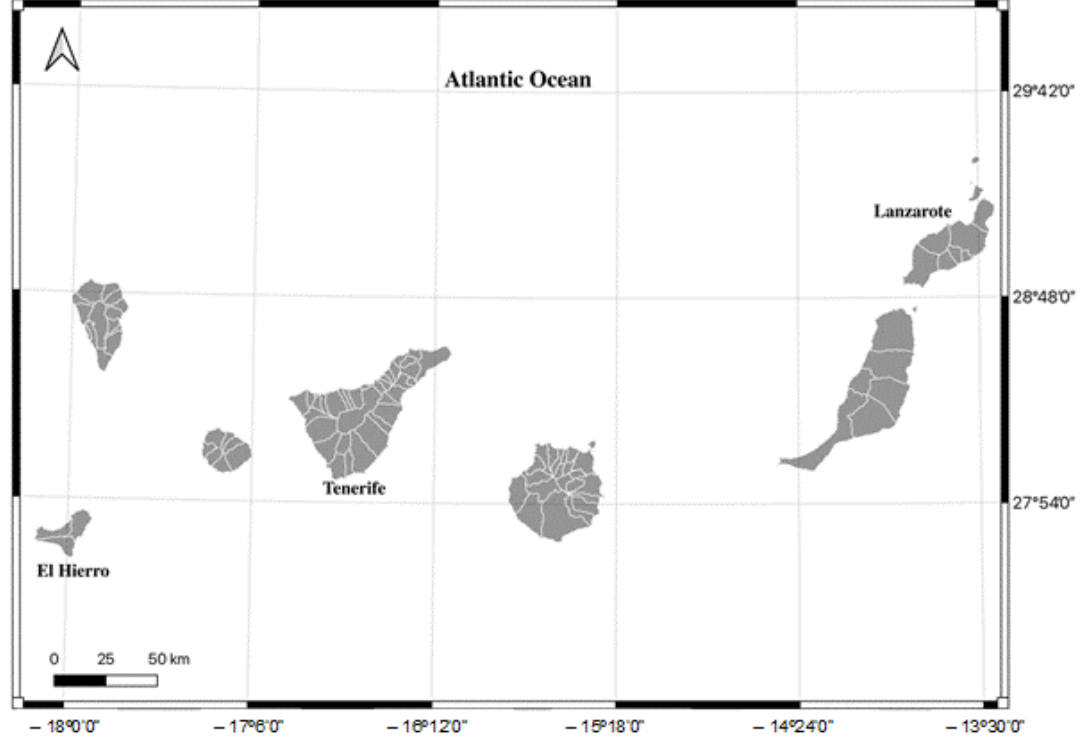
Figure 1. Map showing the location of the study specimens.